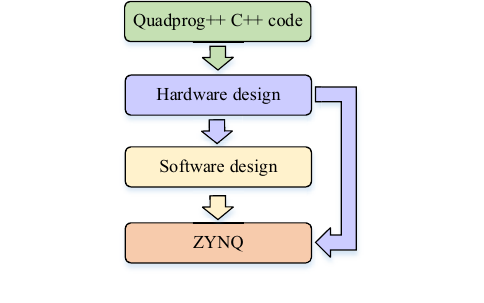
Figure 3 Combined hardware-software